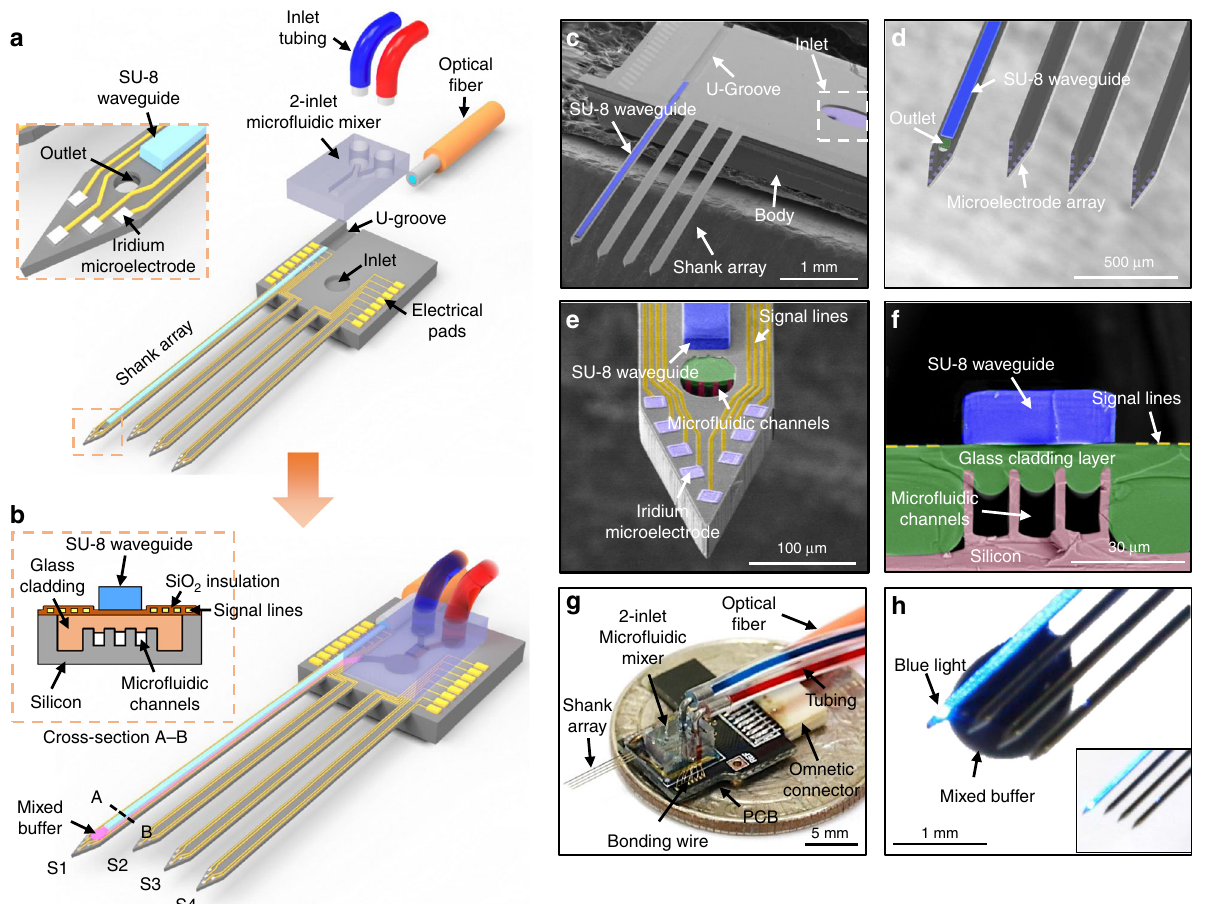
Fig. 1 Fabricated multifunctional multi-shank MEMS neural probe: a Schematic diagram of the respective components before the device packaging with inset showing the probe tip; b Schematic diagram of the packaged device with inset showing the cross-section of the probe shank; c View of the multifunctional MEMS neural probe; d A magni fi ed image of the shank array showing the integrated microelectrode array, the SU-8 waveguide, and the outlet; e Close-in image of a leftmost shank tip with the optical stimulation site and the outlet of the micro fl uidic channel; f Cross-sectional image of the leftmost shank showing the embedded glass cladding and micro fl uidic channels and the SU-8 waveguide; g Optical picture of the packaged multifunctional multi-shank MEMS neural probe; h A magni fi ed image of the shank tip showing transmitted blue light through the SU-8 waveguide and the mixed